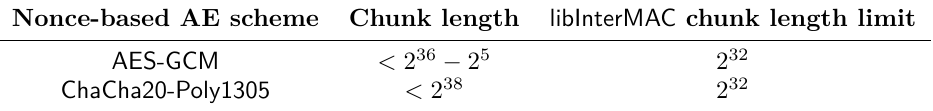
Table 1: The middle column contains derived chunk length restrictions for the internal nonce-based AE schemes implemented in libInterMAC . The right-most column shows the limit on the size of the chunk length implemented in libInterMAC . All lengths are counted in bytes.